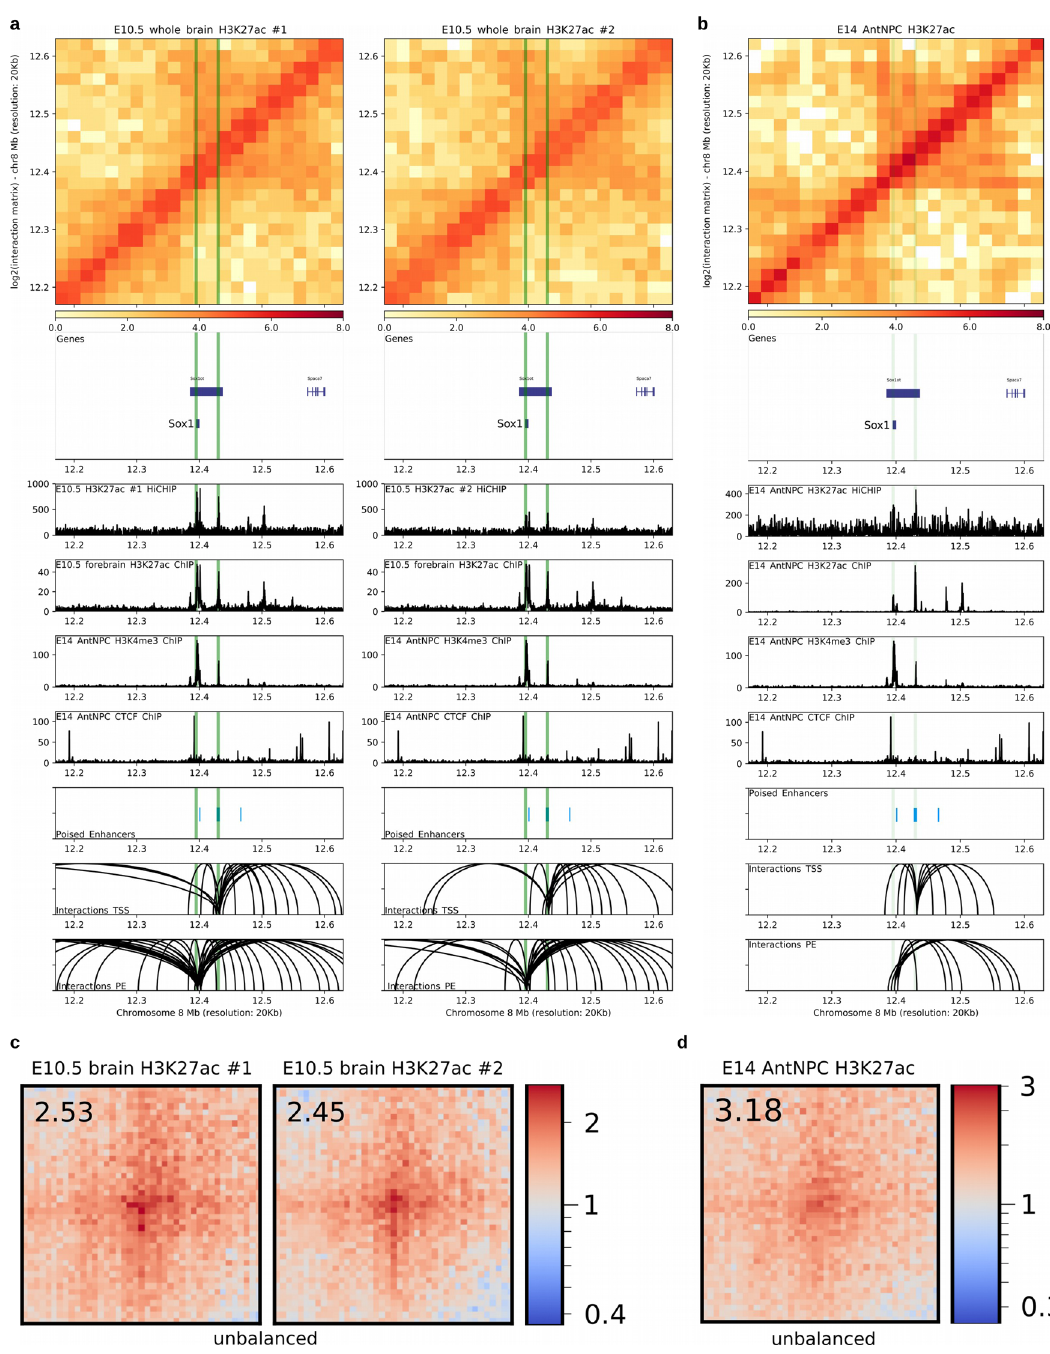
Fig. 5 Interactions between PEs and their target genes are maintained once PE becomes active in either AntNPC or the embryonic mouse brain. a , b H3K27ac HiChIP and ChIP-seq pro fi les generated in E10.5 mouse brains ( a ; two biological replicates) and AntNPC ( b ; both replicates merged), respectively, are shown around the Sox1 locus. Both the Lhx5 TSS and the PE Sox1 ( + 35 kb) are marked with green vertical lines. Upper panel: heatmap of log2 interaction intensities based on H3K27ac HiChIP data generated in E10.5 mouse brain. Two medium panels: 1D HiChIP signals for H3K27ac in E10.5 mouse brain and H3K27ac, H3K4me3, and CTCF (for potential TAD boundaries) ChIP-seq pro fi les in AntNPC. Lower two panels: signi fi cant ( p < 0.01 for E10.5 mouse brains; p < 0.05 for AntNPC; FitHiChIP) interactions were called using the H3K27ac HiChIP PETs (paired-end tags) and loops in which one of the anchors overlaps (±10kb) either the PE Sox1 ( + 35 kb) or the Lhx5 TSS are shown. c , d Signi fi cant (mESC H3K27me3 HiChIP data; p < 0.01; FitHiChIP) interactions between distal PEs (>10 kb from TSS) and ESC bivalent promoters ( n = 526) were visualized as pileup plots using H3K27ac HiChIP data generated in H3K27ac HiChIP data generated in E10.5 mouse brain ( c ) or AntNPC ( d ). HiChIP interaction matrices were coverage-normalized (unbalanced). HiChIP pairwise interactions are shown 250 kb up- and downstream of each PE and bivalent promoter pair. The numbers in the upper left corners correspond to “ loopiness ” values (center intensity normalized to the intensity in the